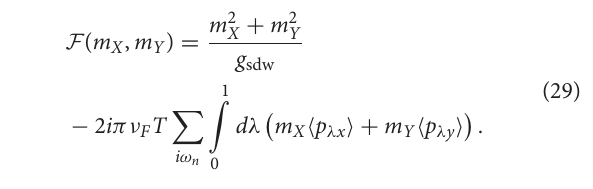
0.5 δ 0 with δ 0 2 π T s where T s is = = 0.1 T s =